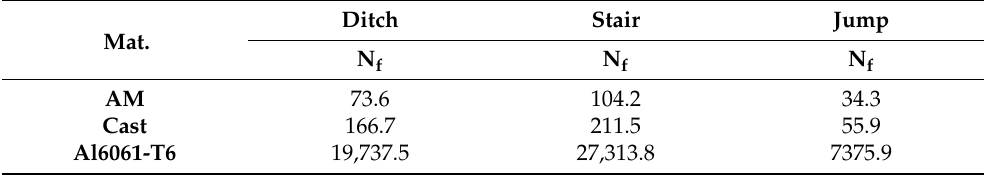
Figure 11. Fatigue lifetime distribution function for each obstacle.